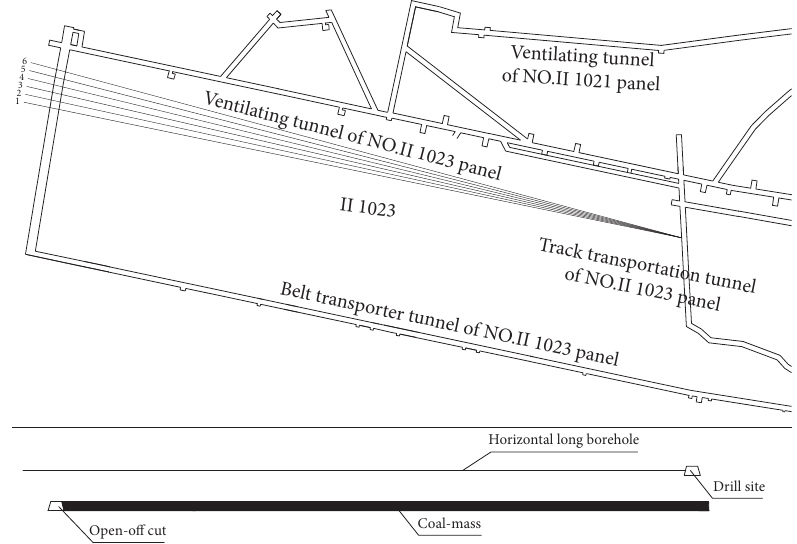
Figure 16: Schematic diagram of horizontal long borehole design in the roof.